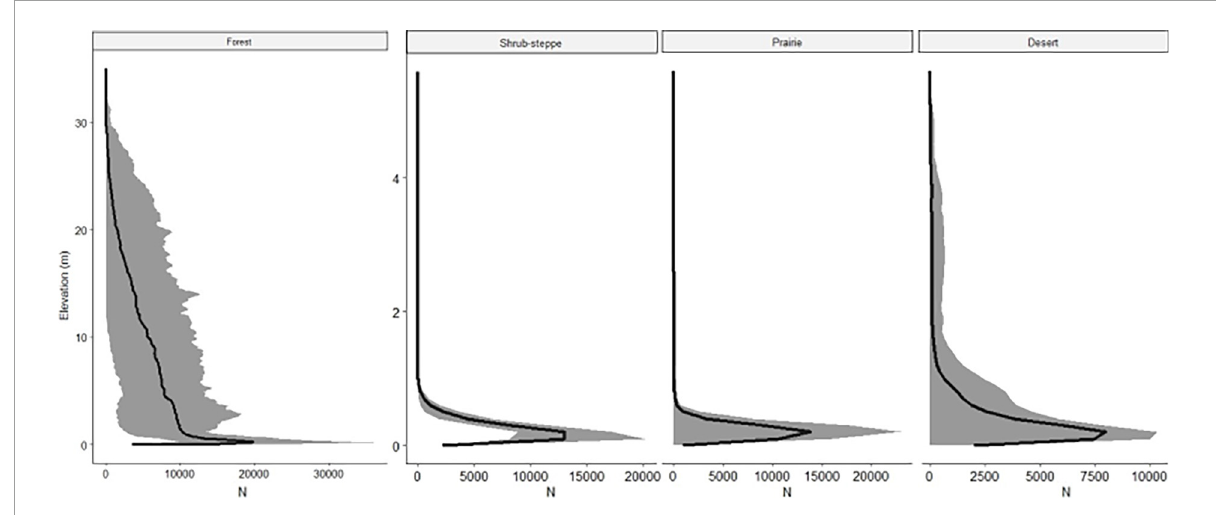
FIGURE4 Vegetation distribution profiles calculated from the lidar point clouds representing the number of voxels (units of space occupied by some vegetation resolution 5 cm 3 , defined as N in the figure) at each elevation (m) above ground. The y-axis scale differs between the forest and the three low-structure ecosystems (shrub-steppe, prairie, and desert). Mean values (line) and ranges (shaded area) for all plots in each of four